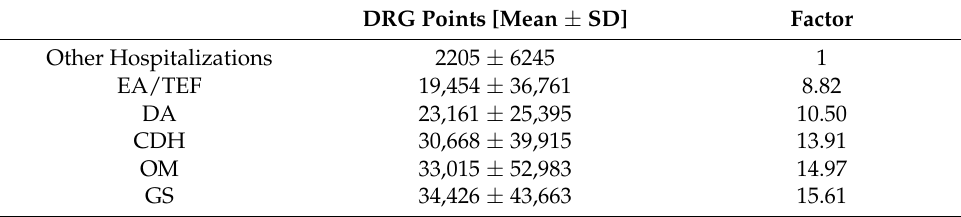
Table 2. Costs as expressed in DRG points per hospital admission and factor comparing the five selected congenital malformations to all other hospitalizations aged 0 to 19